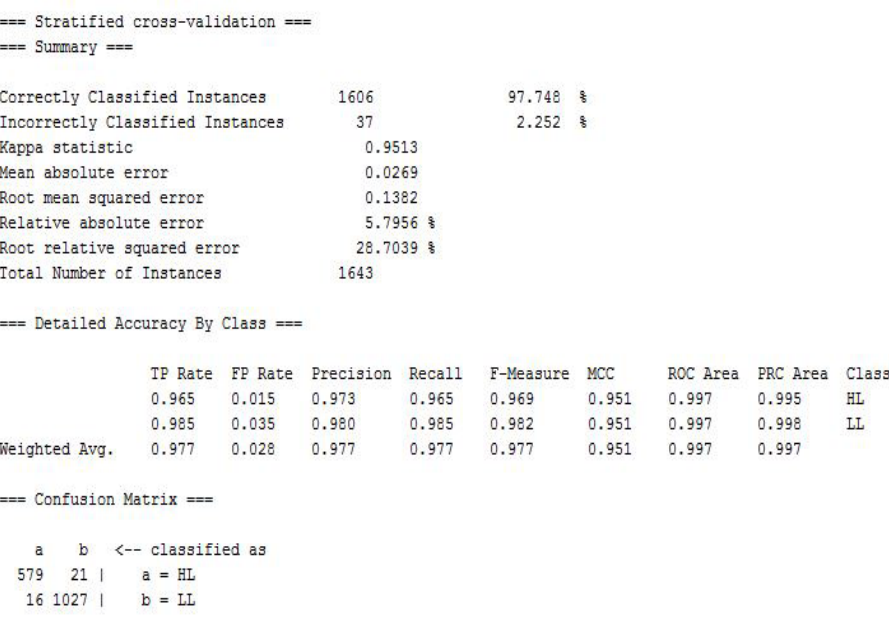
Figure 16: MLP model built with 16 most relevant attributes, using the training dataset